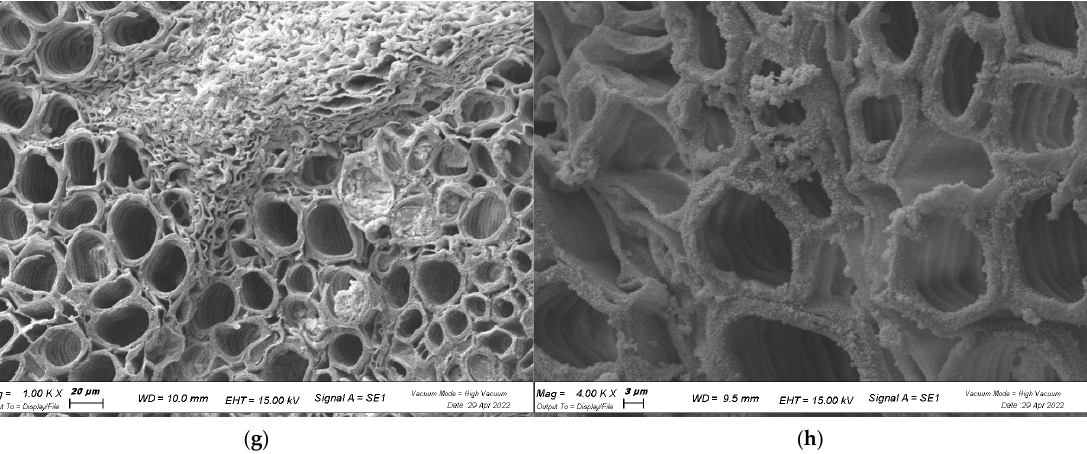
Figure 6. Effects of biofilm formation on biotic surface, SEM visualization: ( a , b ) CTRL samples; ( c , d ) HAMD-MOL; ( e , f ) HA-MOL; ( g , h ); MeOH-MOL. All images are shown at 1 K and 4 K × magnification. Table 1. E ff ects of bio fi lm formation on biotic surface. Total viable colony count data are reported as the mean of three di ff erent experiments performed in triplicate ± standard deviation.